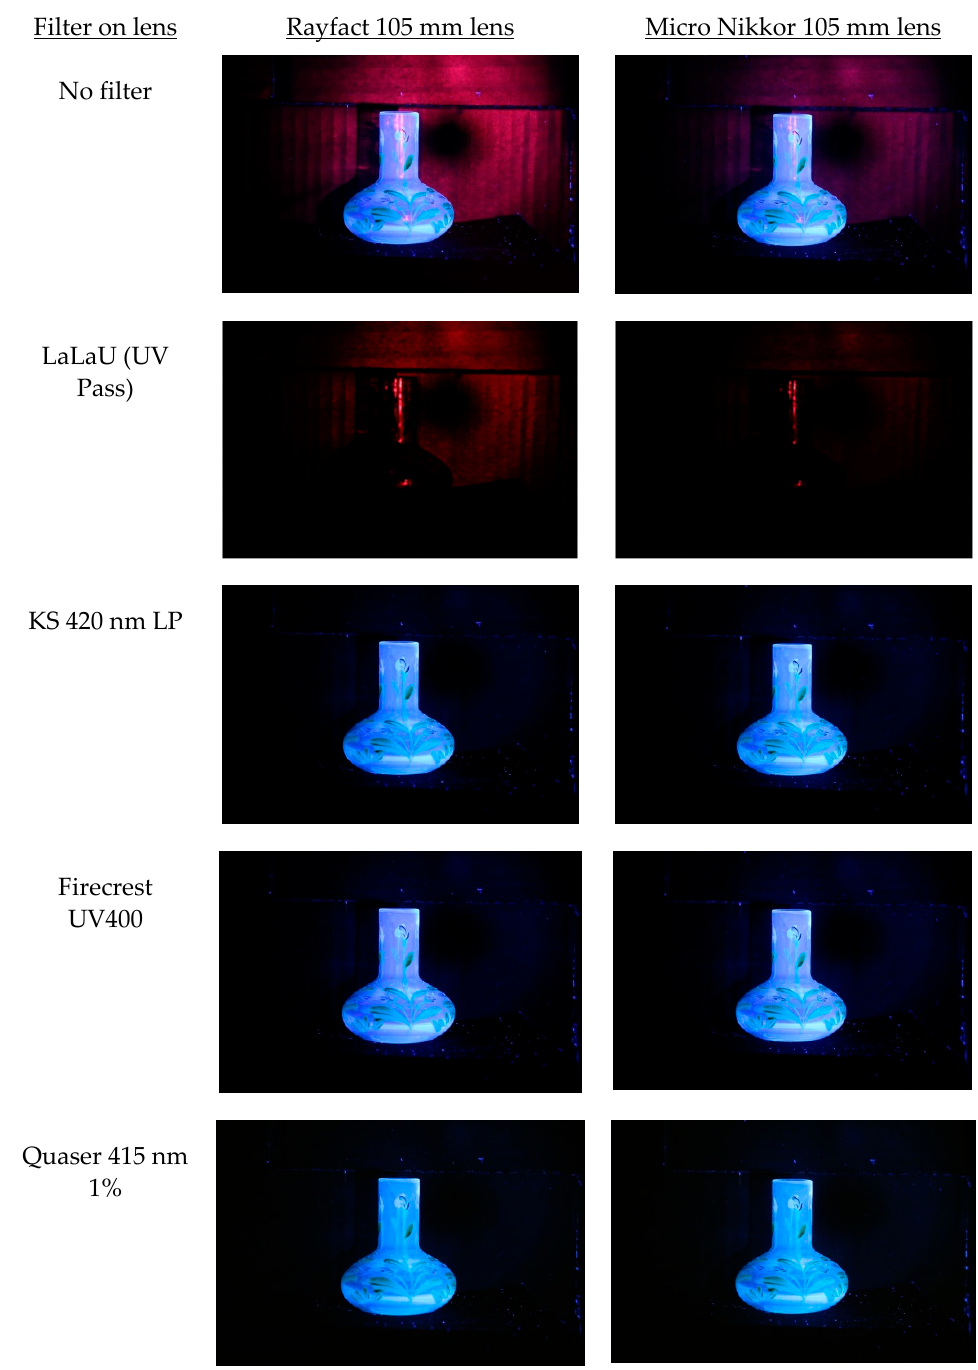
Figure 4. Images of test vase using two lenses (Rayfact 105 mm UV and Micro Nikkor 105 mm) with no filter on the lens, a UV pass filter (LaLa U) and three different UV blocking filters (KS 420 nm LP, Firecrest UV400 and Quaser 415 nm 1%). An unmodified Canon EOS 6D was used to capture the images.